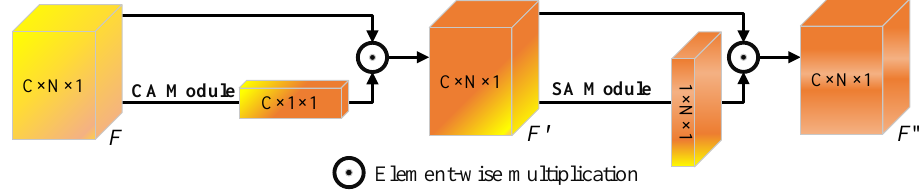
Figure 3. Channel-Spatial Attention (CSA)